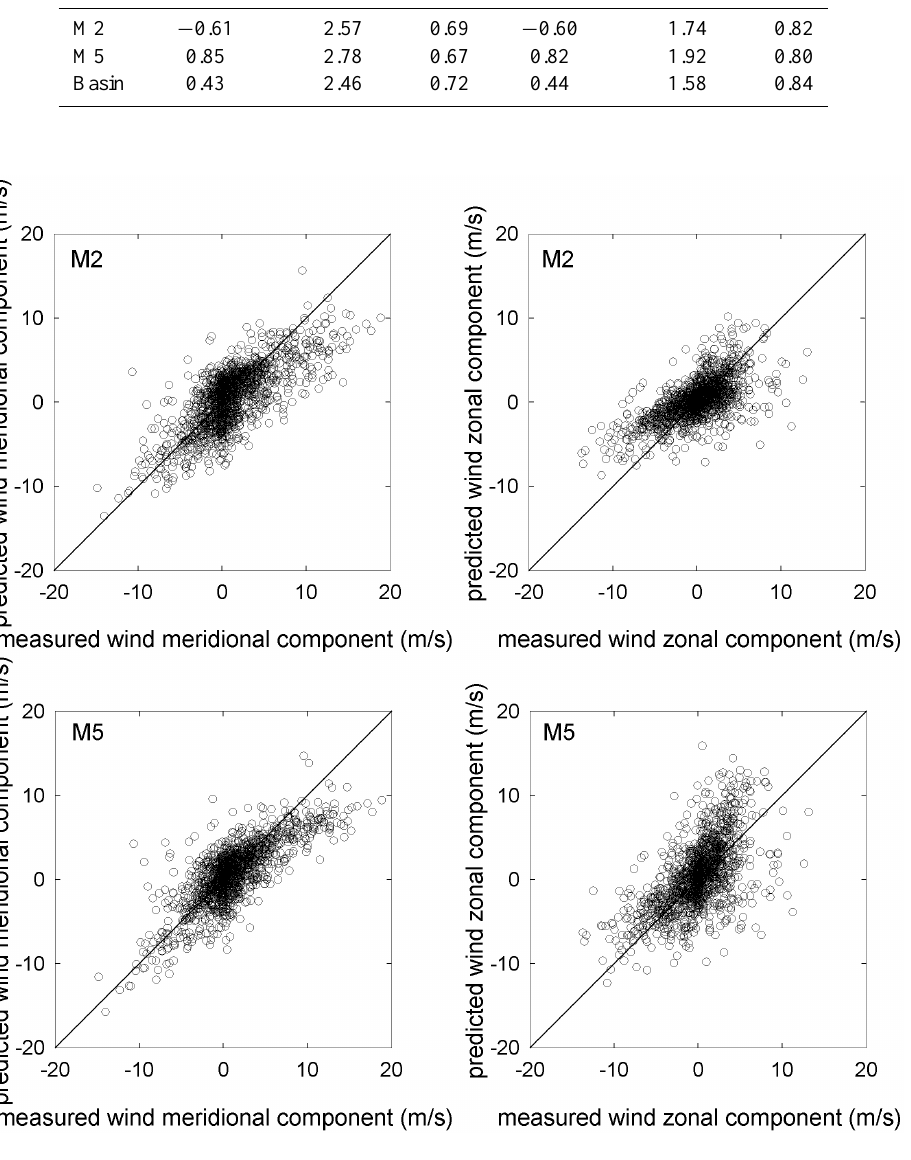
by the lack of the extremes. In order to avoid arbitrary in- achieved for the two grid points closest to the buoy position